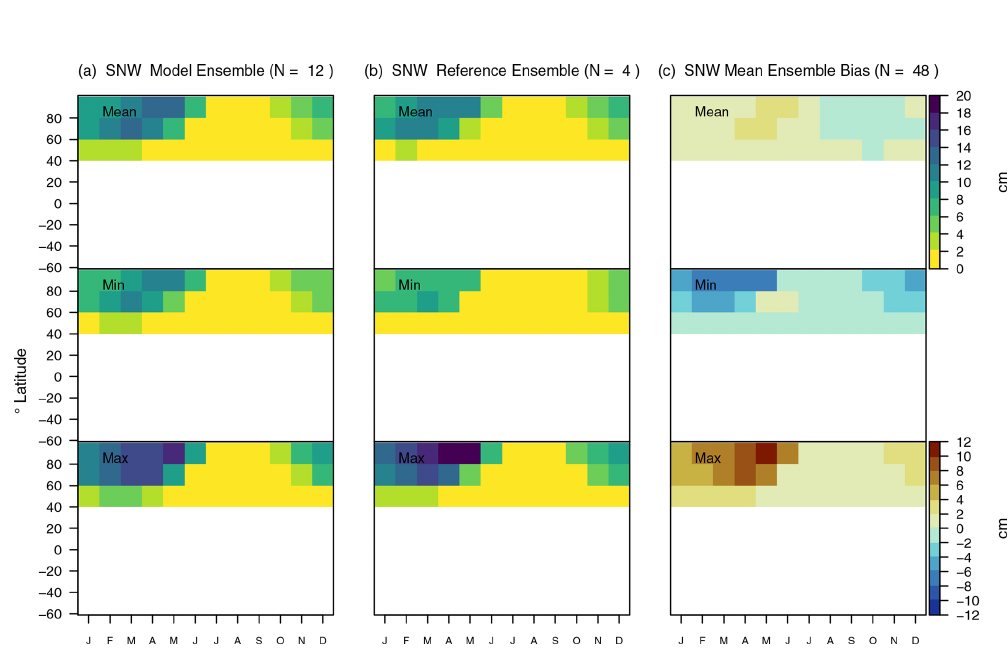
Figure A15. Same as in Fig. 8 but for snow water